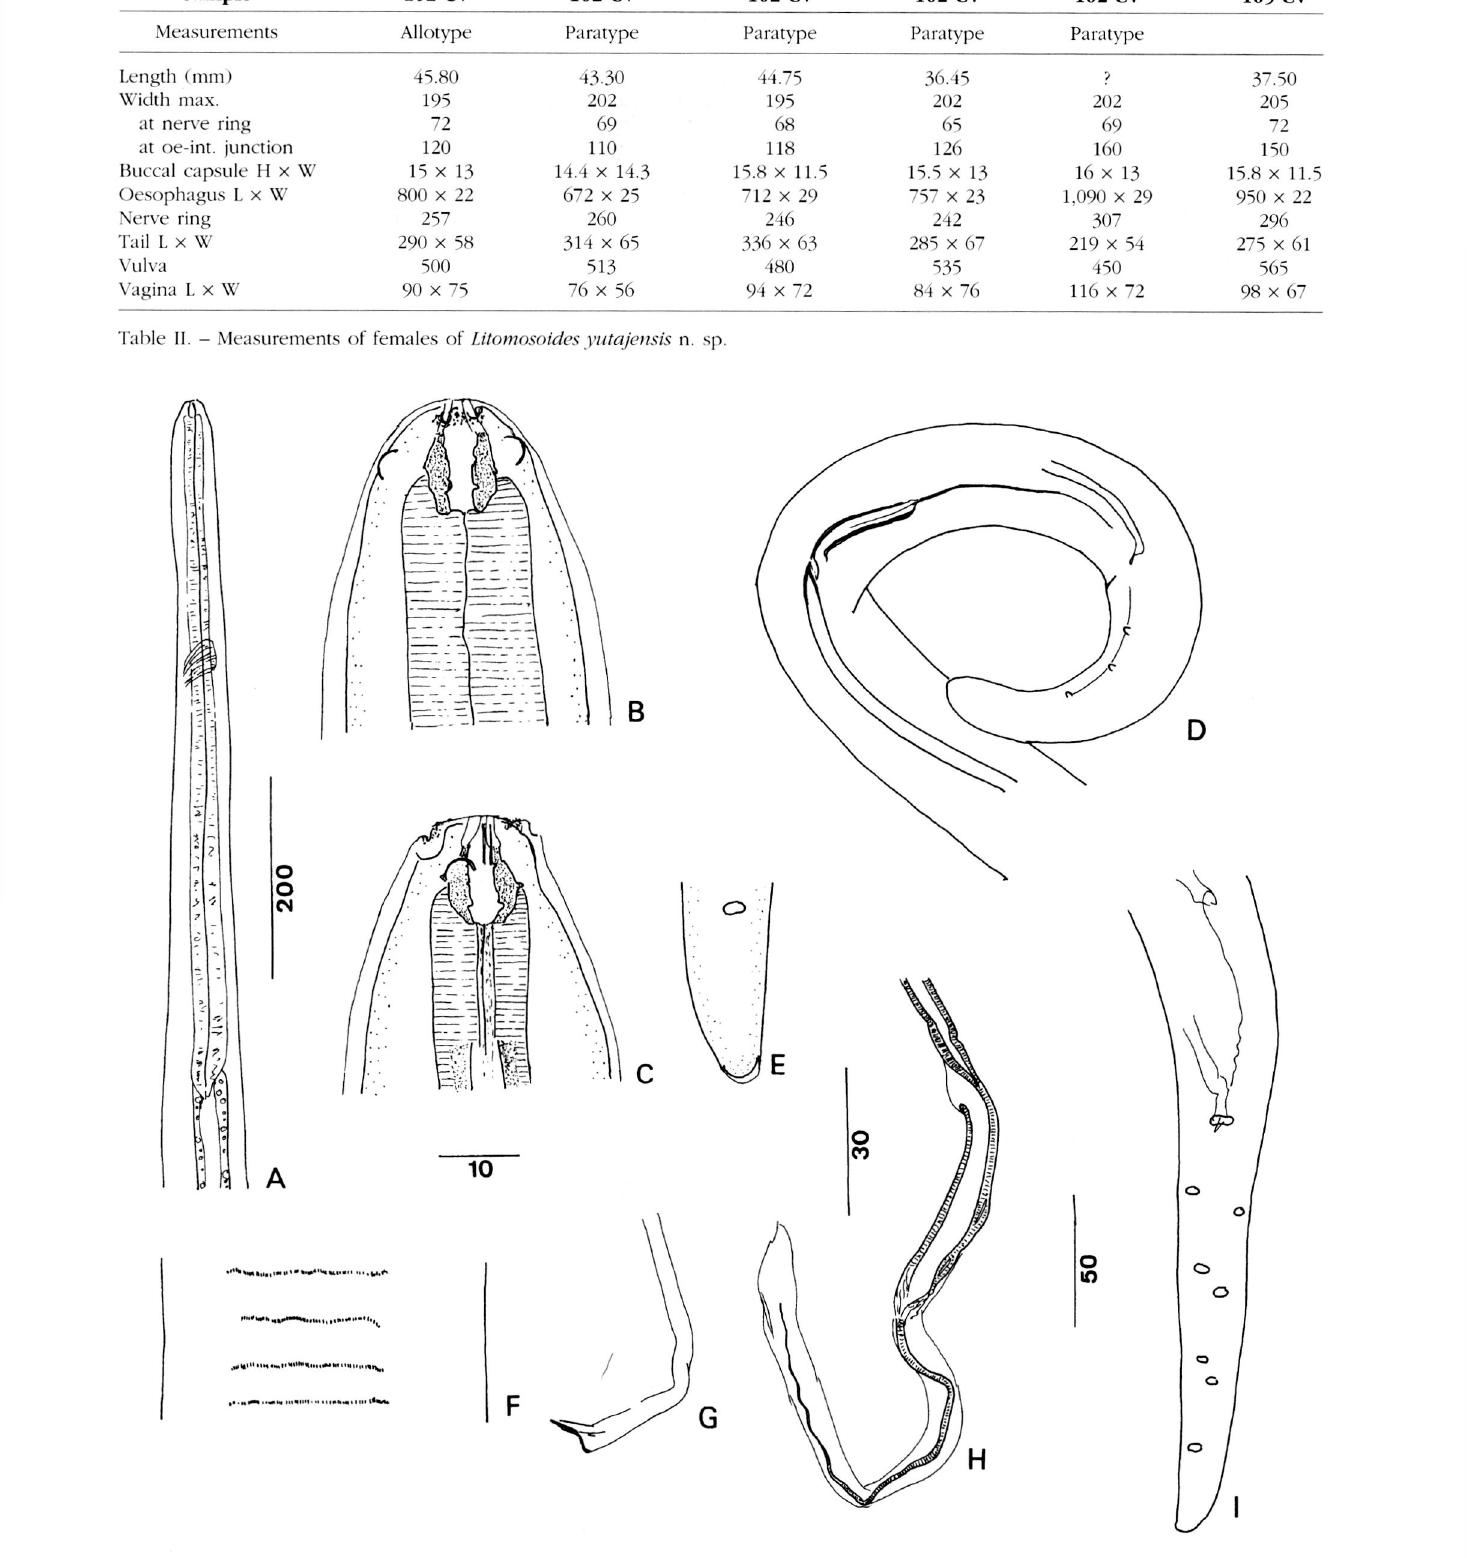
Fig. 1. - Litomosoides yutajensis n. sp. Male. A. Anterior region, left lateral view (holotype). B, C. Head, ventral and left lateral views, res pectively (holotype). I). Posterior region, left lateral view. E. Tail extremity, ventral view. F. Area rugosa at mid-length, ventral view. G. Right spicule, lateral view, right lateral view. H. Lamina of left spicule (dissected out from spicular sheath). I. Tail, ventral view. Scales in µm: A, 200; B, C, 10; D, 1. 50; E, F. G. H, 30.